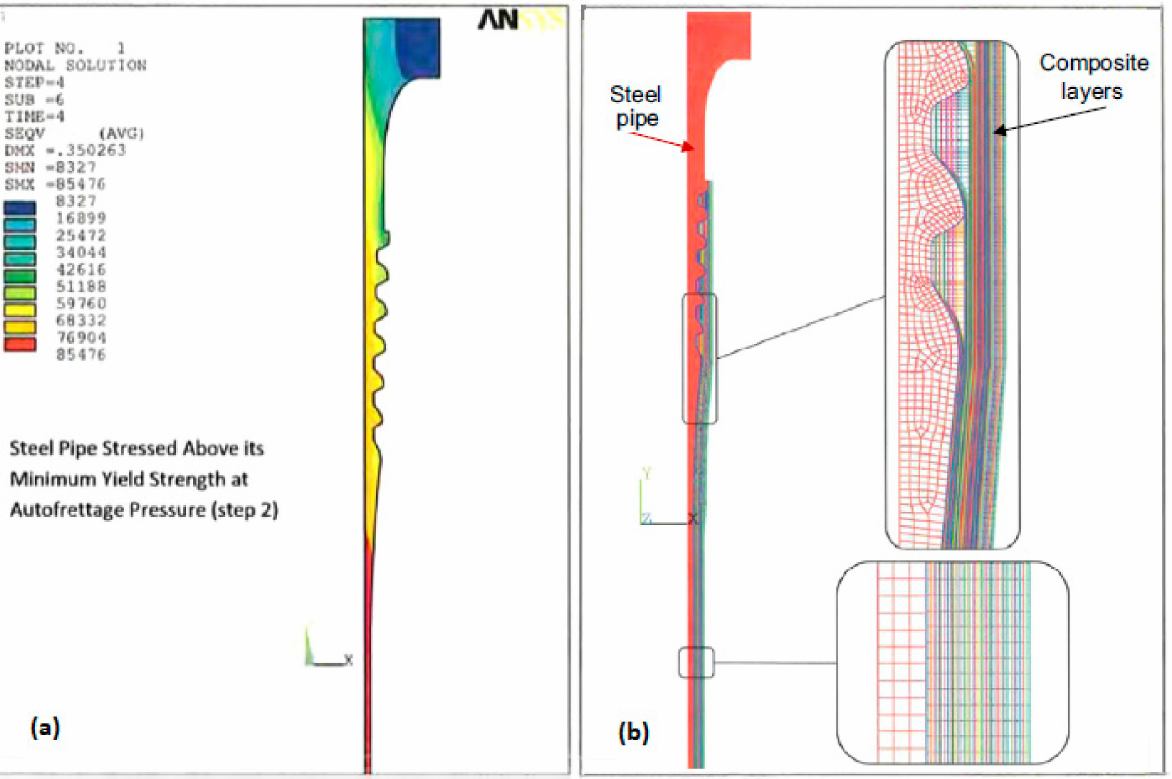
Figure 12. Finite element model of composite riser end-fitting joint in ANSYS, showing ( a ) Compres- sion stress in the steel pipe, and ( b ) the local design for the riser joint model (Permission to reuse was obtained from (i) OTC’s OnePetro Publisher and (ii) Elsevier Publishers; Source: [109,110,160]. Published: (i) 06 May 2013; Copyright date: 2013; (ii) 22 December 2015; Copyright date: